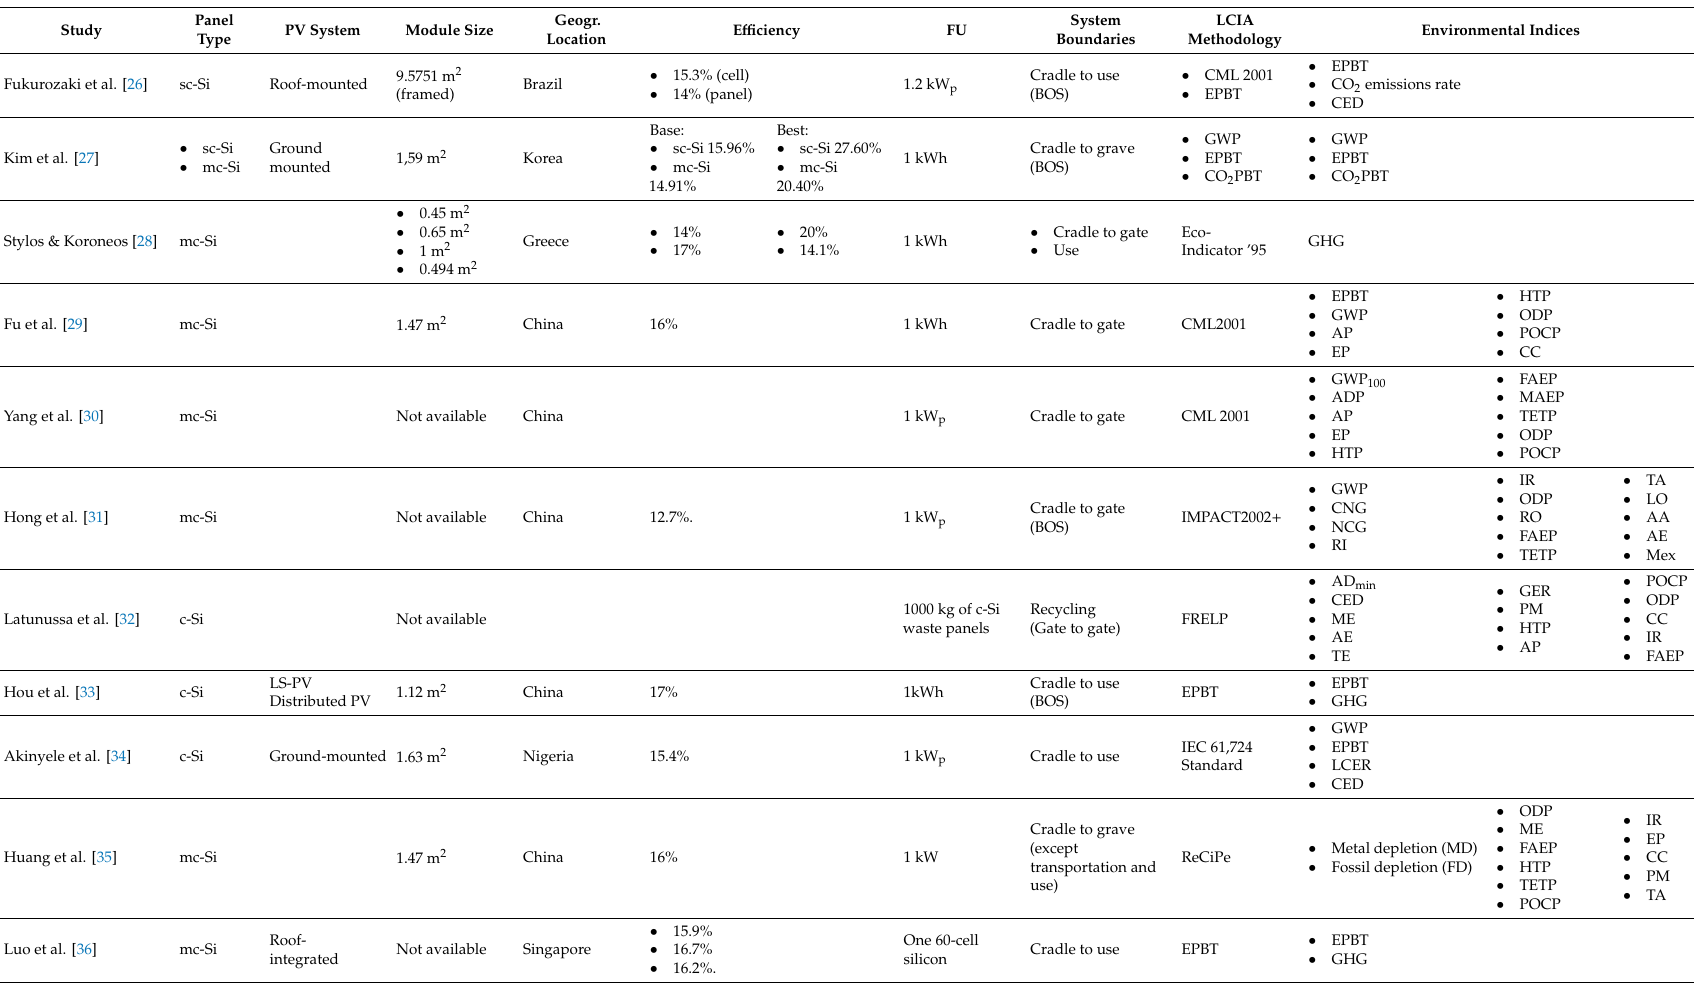
Table 7. Summary of key-parameters and methodological aspect of the examined case studies (1st